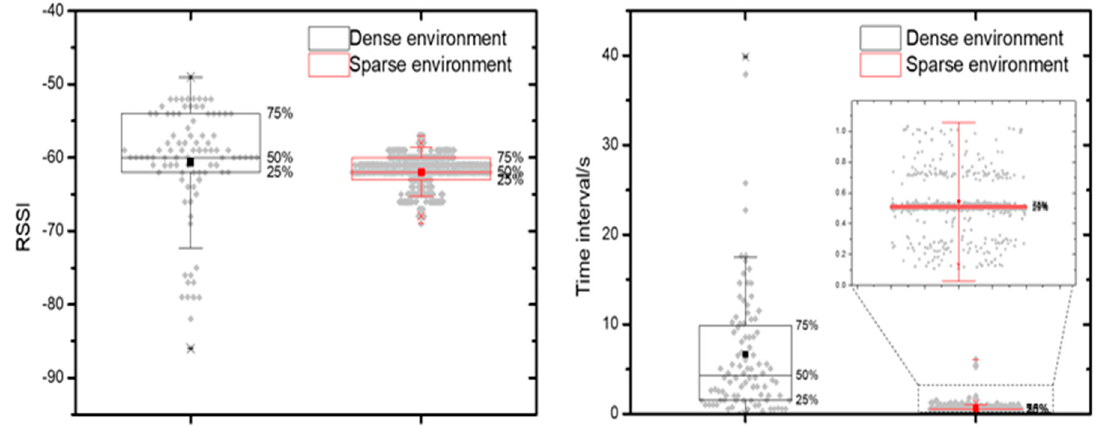
Figure 1. Received Signal Strength Indicator (RSSI) value and the scanning time interval of the Bluetooth Low Energy (BLE).